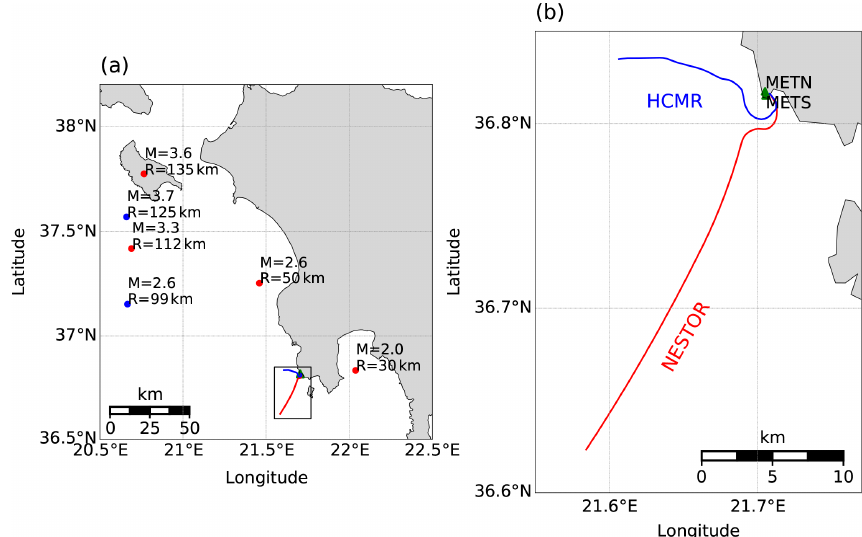
Figure A1. Map of earthquake, seismometer and cable locations in Greece. The NESTOR and HCMR cables (lines) and their recorded earth- quakes (circles) are indicated in red and blue, respectively. (a) Catalog magnitudes and hypocentral distances are indicated near earthquake locations. (b) The region marked by a black rectangle in (a) , with cable layout and broadband seismometers (green triangles).